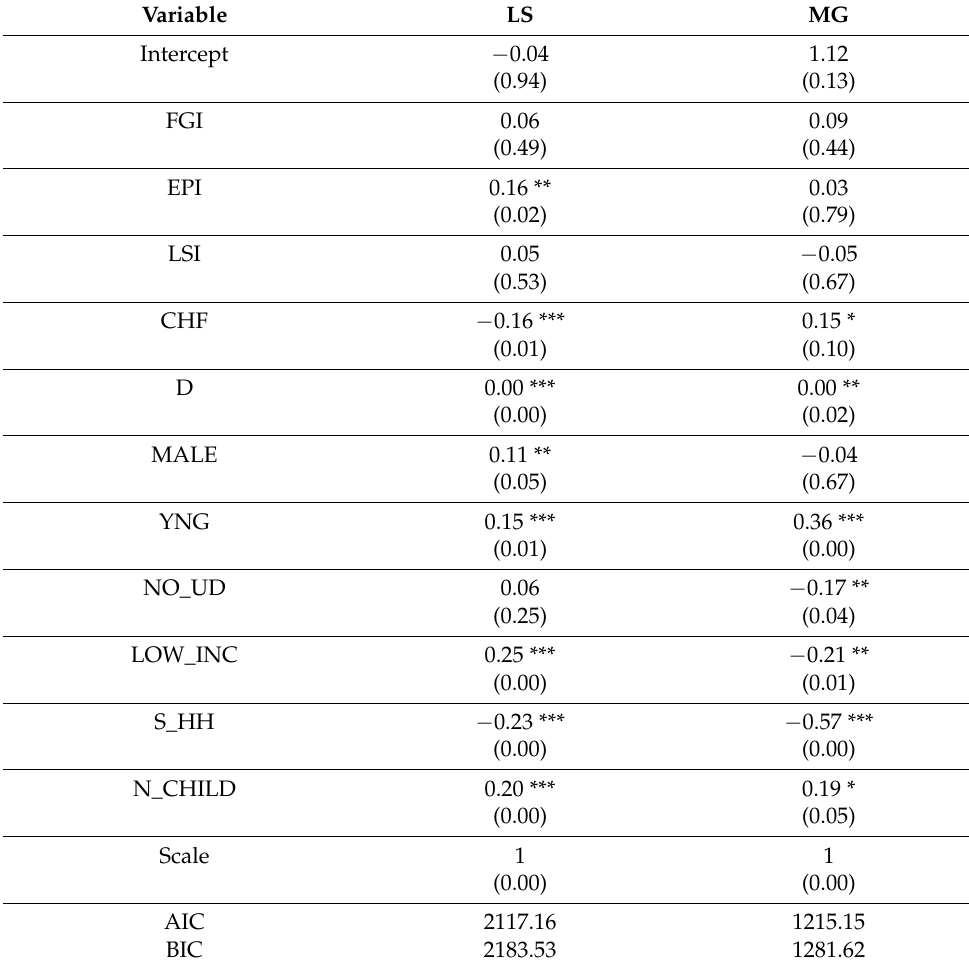
Table 3. Parameter estimates, standard errors (in parentheses) and goodness-of-fit statistics for lifesaving program (LS) and monetary gains (MG) for all delays (binomial model, logit link function, base state of explanatory variable: DR >